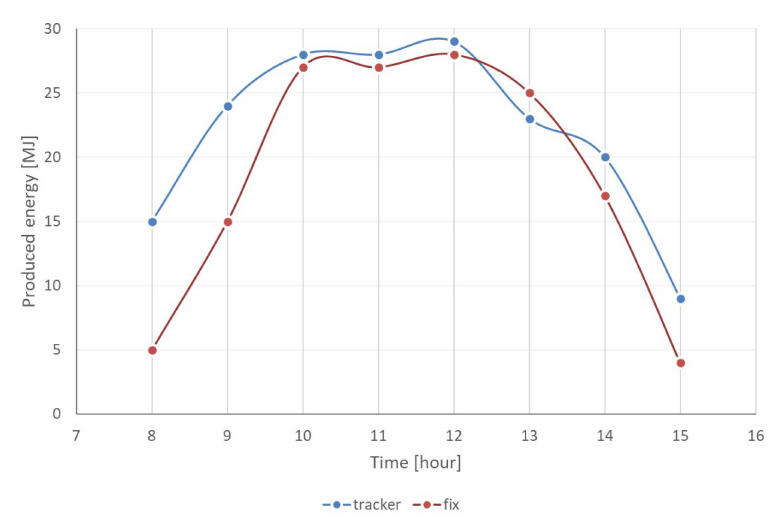
Figure 15. Cumulative daily profiles of the obtained energy for a system with active rotation and for a static system without rotation of thermal collectors. Tracker—21 March 2019 and 2 April 2019 for system with active rotation, fix 29 March 2019 and 30 March 2019 for static system without rotation of thermal collectors. For the validation of the system of rotation and the static state (south direction), hourly values of daily incident HGR radiation and interval hourly comparisons of the collector outlet temperature were processed. Average hourly value of daily radiation Q HGR ( i = 9, 10, . . . , 16) of the collectors is presented in Figure 16. For the Q HGR minimum intensity of global radiation was processed Q HGR (cid:17) (cid:16) (cid:104) t (cid:105) intensity of the Q HGR , at the hourly interval (cid:104) t (cid:105) , max h , i each i interval.